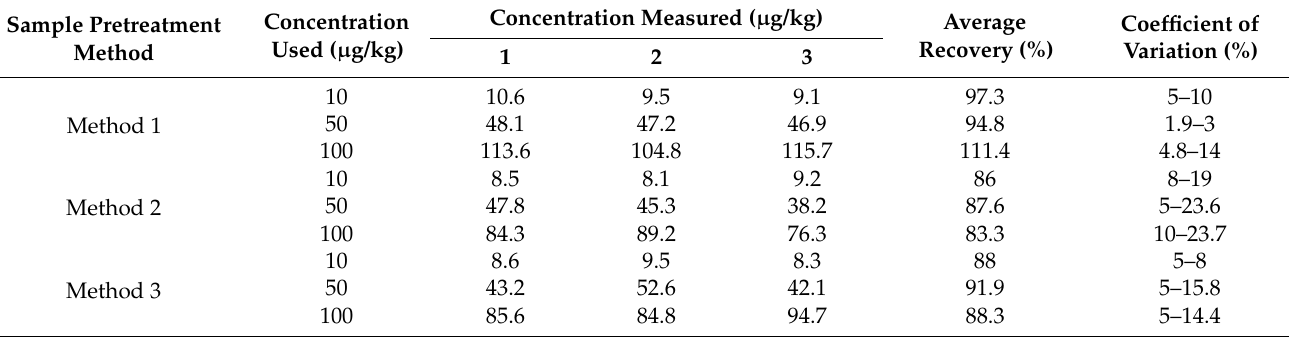
Table 3. Comparison of sample pretreatment methods and determination of